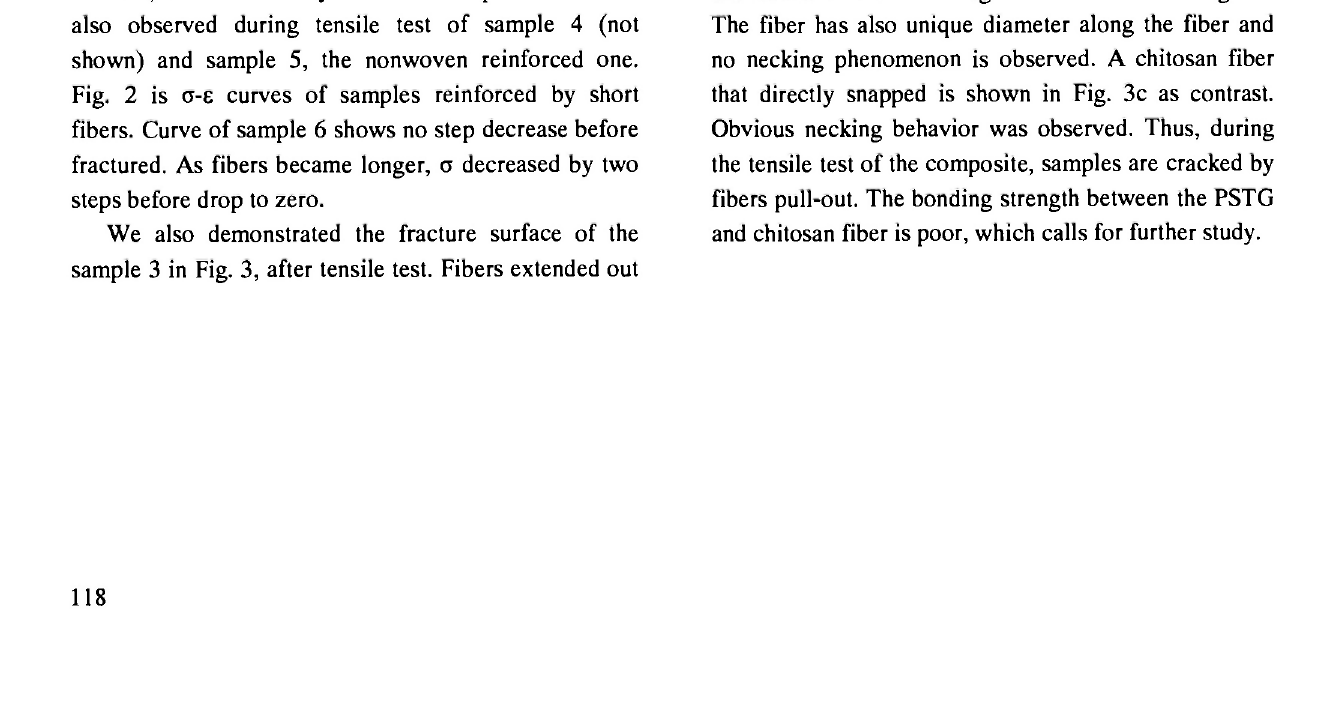
also observed during tensile test of sample 4 (not shown) and sample 5, the nonwoven reinforced one. Fig. 2 is σ-ε curves of samples reinforced by short fibers. Curve of sample 6 shows no step decrease before fractured. As fibers became longer, σ decreased by two steps before drop to